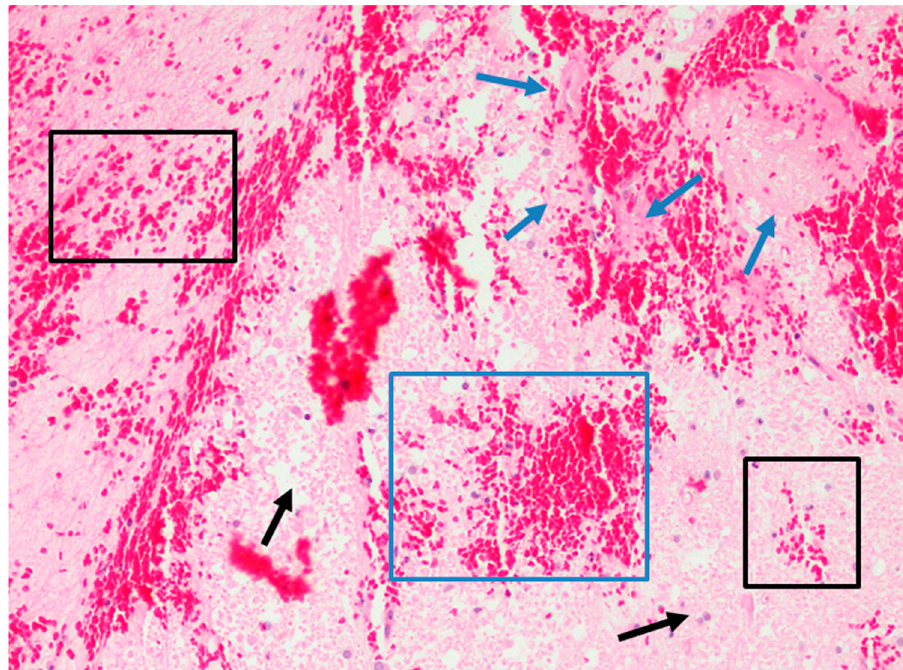
Figure 2. H&E section (×20) showing distribution pattern of erythrocyte extravasations in cerebral ischemia. Intraparenchymal zone in which erythrocyte extravasations are partly diffused (black box), partly wider (blue box), in a context of ischemic necrosis (blue arrow) and edema with aspects of hypoxic cell damage (black arrow).